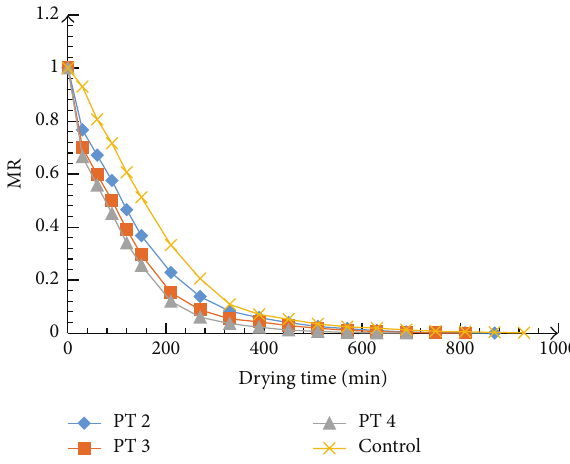
Figure 1: Variation of MR versus drying time at microwave power 300 W.